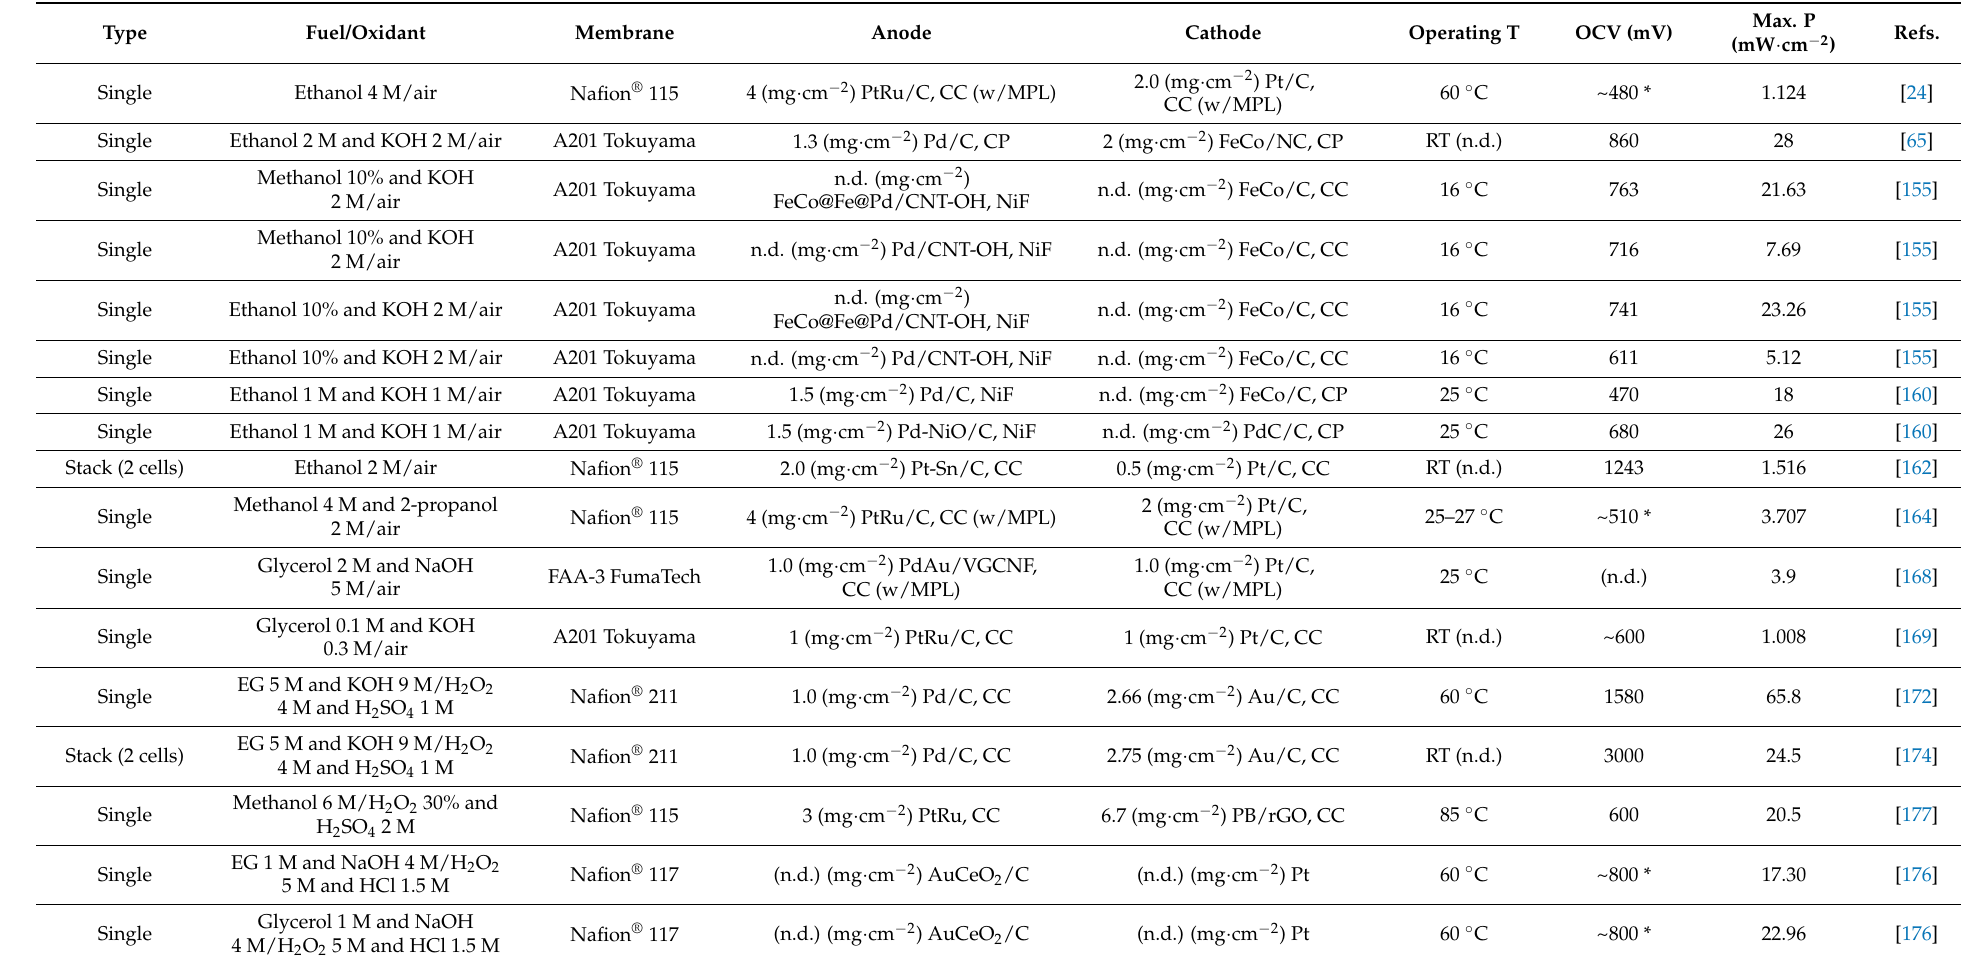
Table 3. Best performance of PS-DAFCs devices (single or stack), along with the principal fuel and oxidant